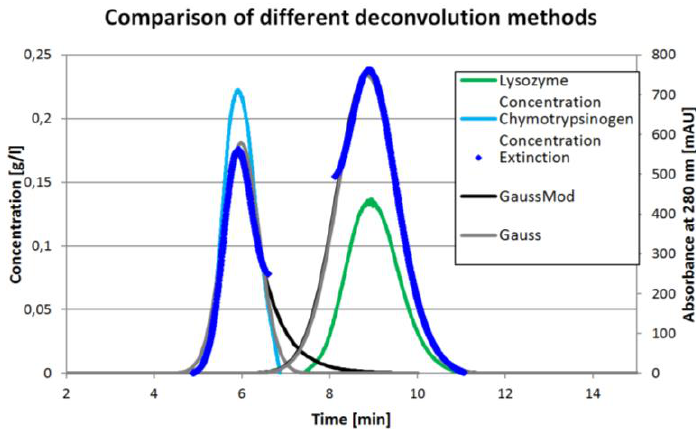
Figure 4. Comparison of the different peak deconvolution methods.